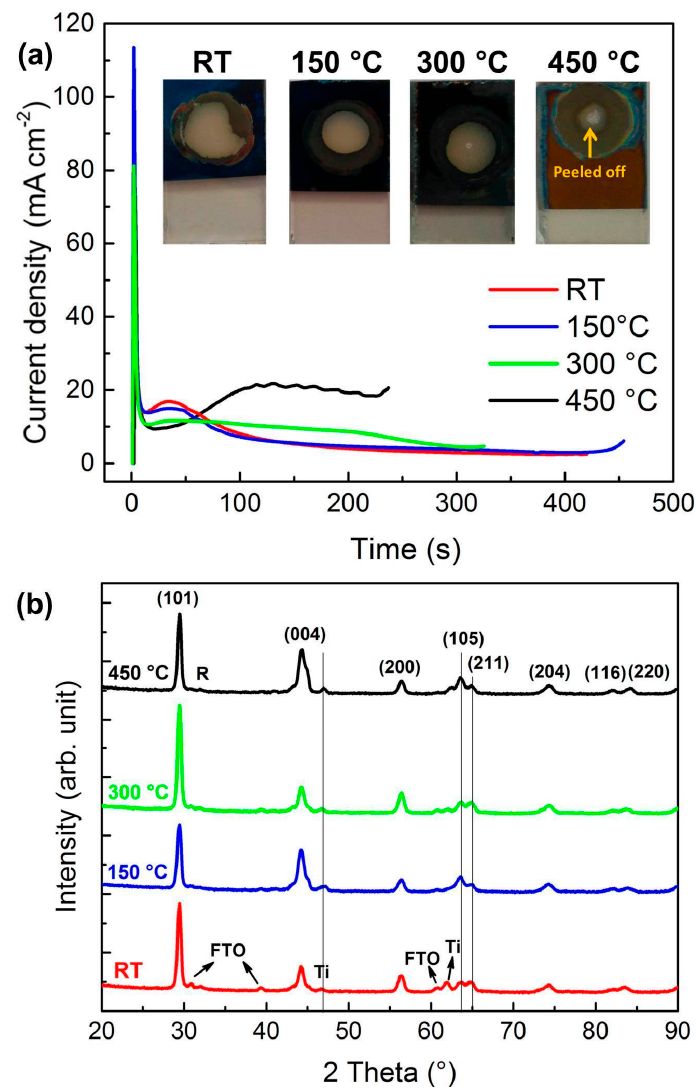
Figure 5. ( a ) Current density versus time plot recorder during the electrochemical anodization of titanium films with the pictures of grown and annealed TiO 2 nanotubes; ( b ) XRD spectra of TiO 2 nanotubes after thermal annealing at 450 °C for 3 h in air.